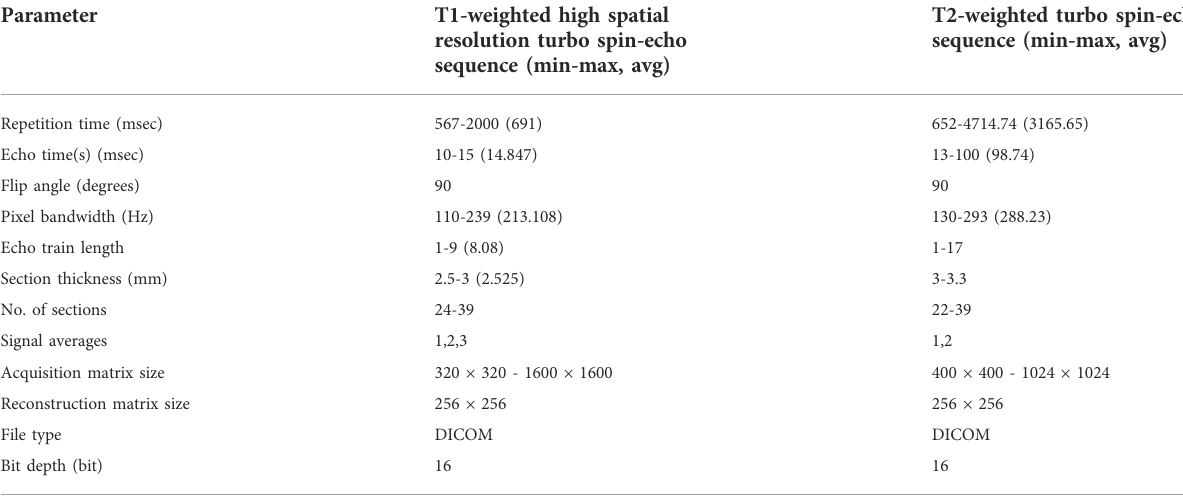
TABLE 1 Parameters for the knee MRI sequences used to locate ACL